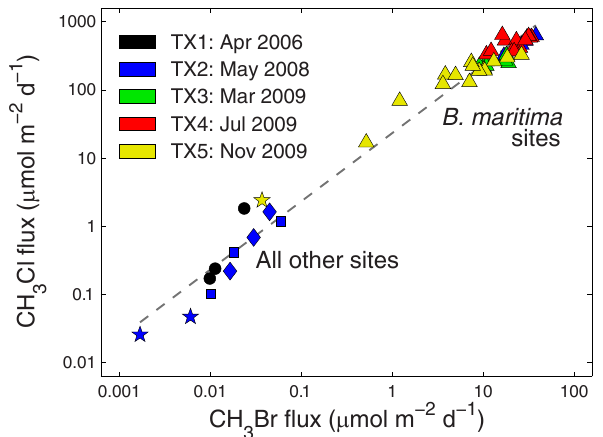
Figure 1. Net fluxes of CH 3 Cl and CH 3 Br for all field sites in south Texas. Triangles: B. maritima ; squares: fresh Sargassum ; dia- monds: decaying Sargassum ; circles: other vegetation ( M. littoralis , A. germinans , B. frutescens ), stars: vegetation-free control. Note the log–log scale. The gray dashed line shows the overall average 23 : 1 molar ratio. Two chambers that had small negative fluxes are not